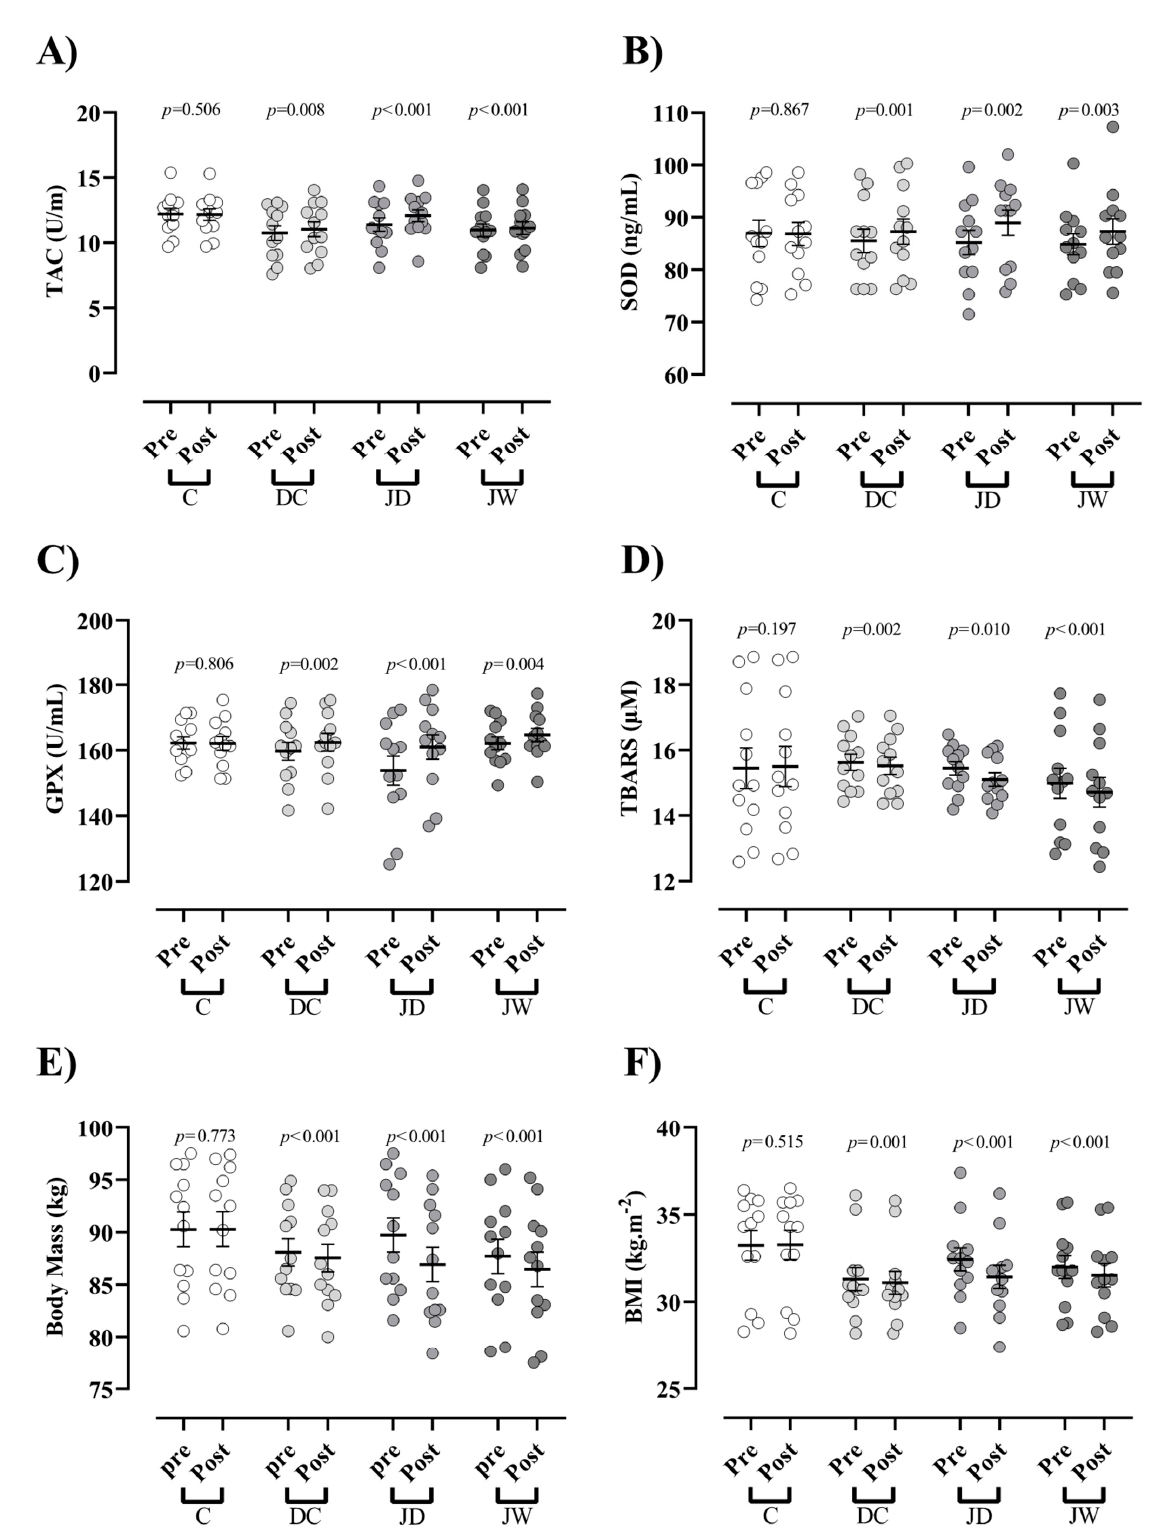
Figure 2. ( A ) Total antioxidant capacity (TAC); ( B ) superoxide dismutase (SOD); ( C ) glutathione peroxidase (GPx); ( D ) thiobarbituric acid reactive substances (TBARS); ( E ) body mass; ( F ) body mass index (BMI). C , control; DC , dark chocolate consumption; JW , jump rope exercise + white chocolate consumption; JD , jump rope exercise + dark chocolate consumption. Error bars indicate standard error of the mean